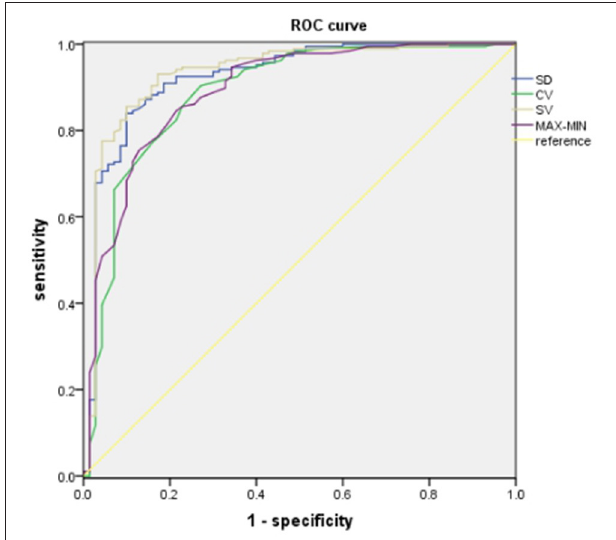
FIGURE 2 | ROC analysis of PP variability and 3-month unfavorable outcomes. PP, pulse pressure; SD, standard deviation; CV, coefficient of variation; SV, successive variation; 1 BP, maximum–minimum difference.